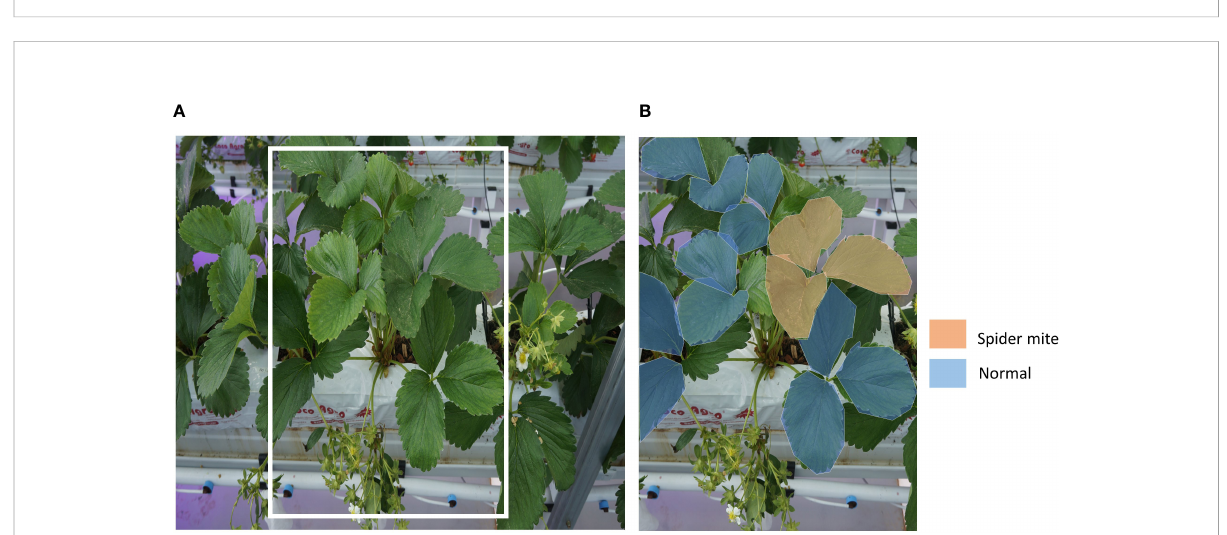
FIGURE 3 An example of strawberry plant image data. (A) A raw image from the data acquisition system. Yellow boxed part is for an example of data labeling. (B) An example of labeling of normal leaves and leaves with early symptoms of spider